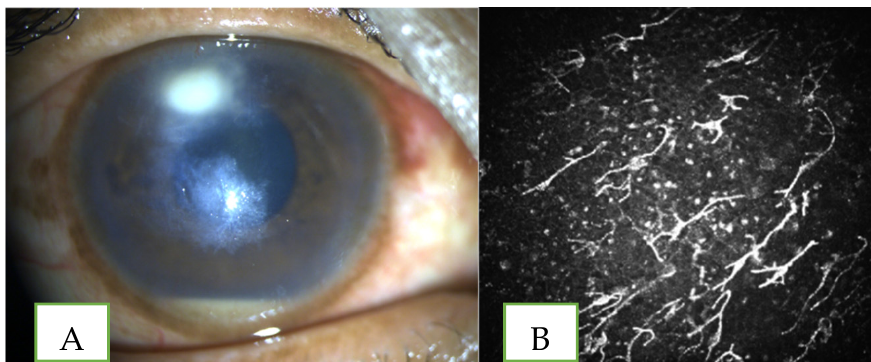
Figure 4. Clinical photograph ( A ) in a case of non-healing keratitis with 2 satellite areas of deep infiltrates and 0.5 mm hypopyon ( B ) IVCM pictures of the patient showing branching refractile elements suggestive of fungal